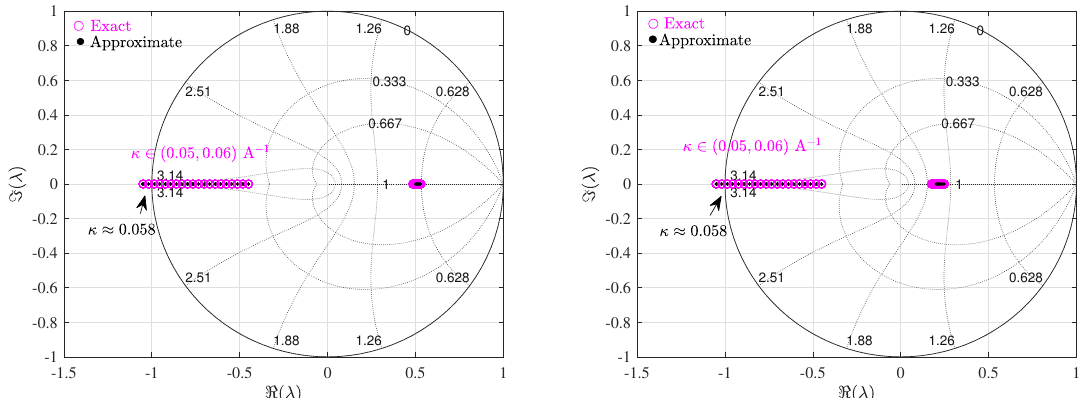
Figure 9. Floquet multipliers loci from the exact and the approximate expression of the monodromy matrix as the bifurcation parameter κ i is varied for left: i ref = 50 A and right: i ref = 80